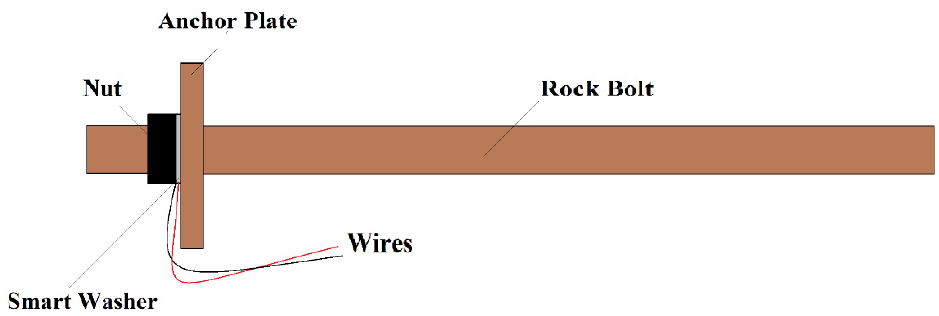
Figure 10. Design of smart washer in a rock bolt specimen.